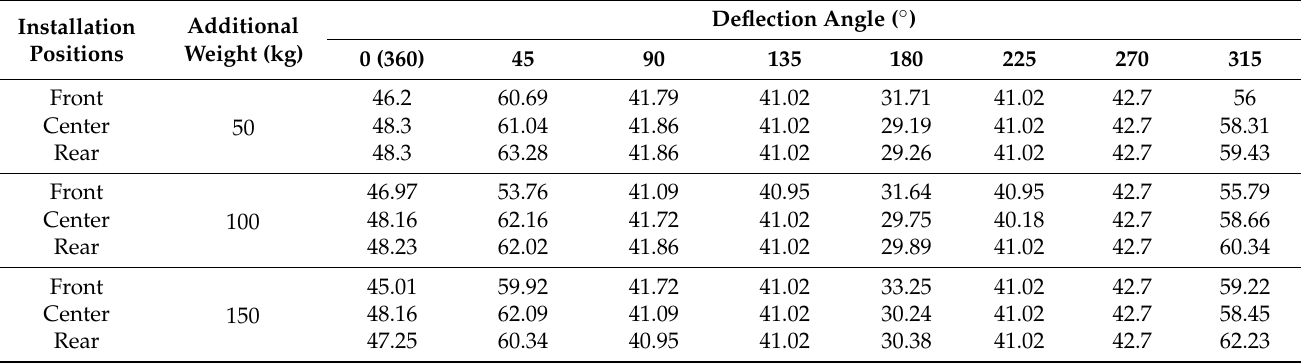
Table 3. The rollover angles ( ◦ ) for different additional weights on different positions of the radish